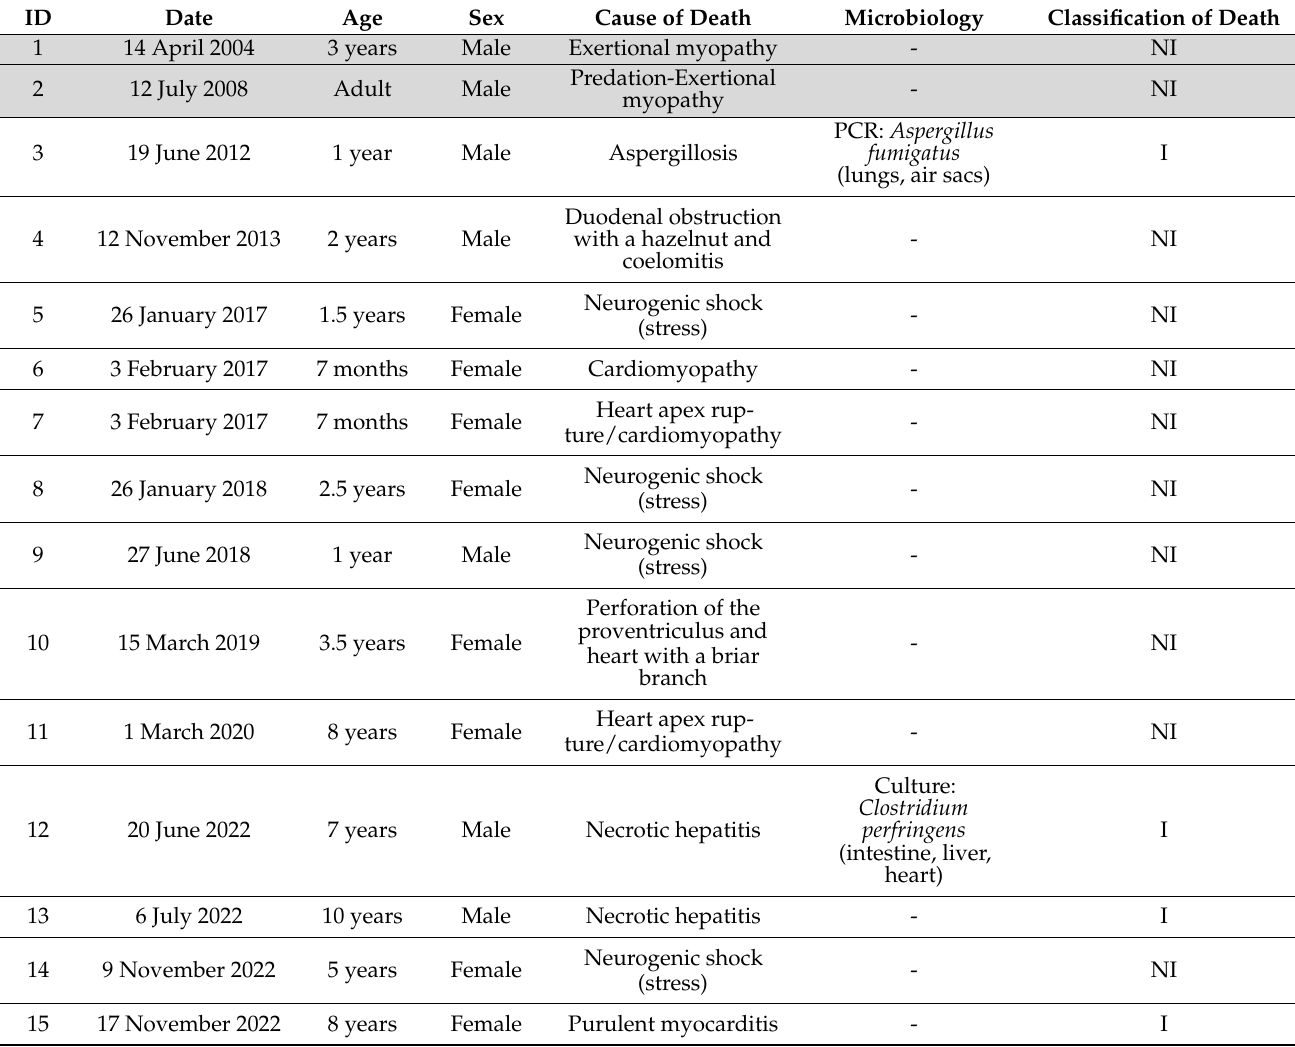
Table 2. Available data, cause of death and classification of death in adult Cantabrian capercaillies ( Tetrao urogallus cantabricus ) necropsied in